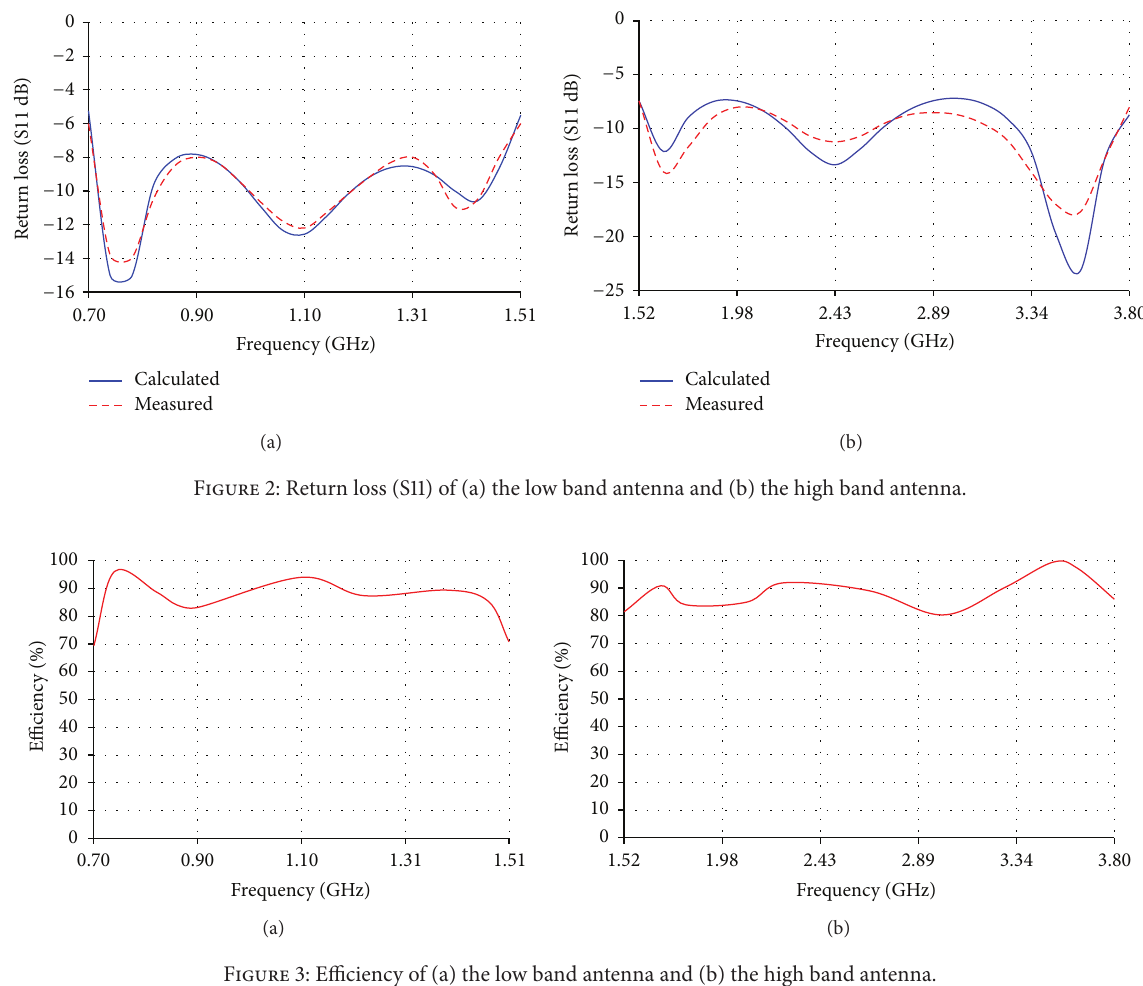
Figure 3: Efficiency of (a) the low band antenna and (b) the high band